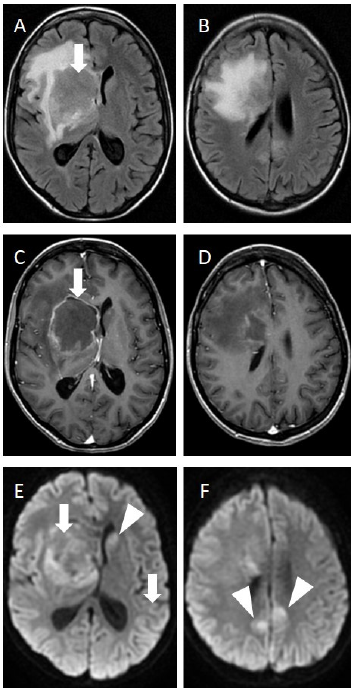
Figure 1. MRI of the brain. Large tumour in the right caudate nucleus with contrast enhancing margins ( C , D ), surrounding vasogenic edema ( A , B ) and restricted diffusion ( E , F ) within the lesion (arrow). Small lesions with vasogenic edema, restricted diffusion and contrast enhancement in left caudate nucleus and both parietal lobes